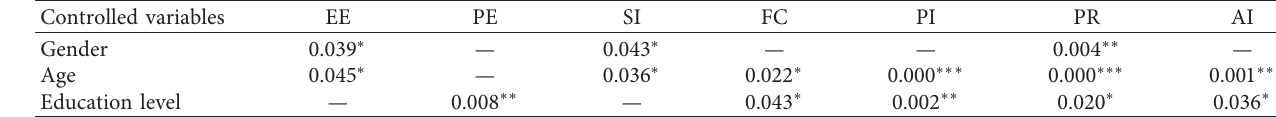
Figure 3: Analysis results of the structural model. Note: the solid arrows represent the paths with significant impacts, and the dotted arrow represents the path with insignificant impact. ∗∗∗ P < 0 . 001, ∗∗ P < 0 . 01, and ∗ P < 0 . 05. Table 8: Results of ANOVA ( P